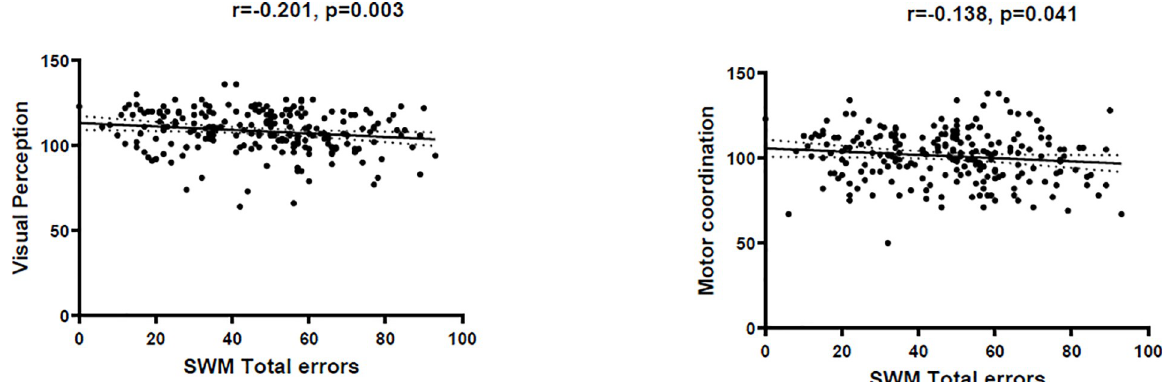
Fig 3. Correlations between spatial working memory and VMI performances in community population. The Pearson correlation analyses were conducted with age and IQ as covariant. The left picture showed the correlation between spatial working memory and visual perception (r = -0.201, p = 0.003). The right picture showed the correlation between spatial working memory and motor coordination (r = -0.138, p =